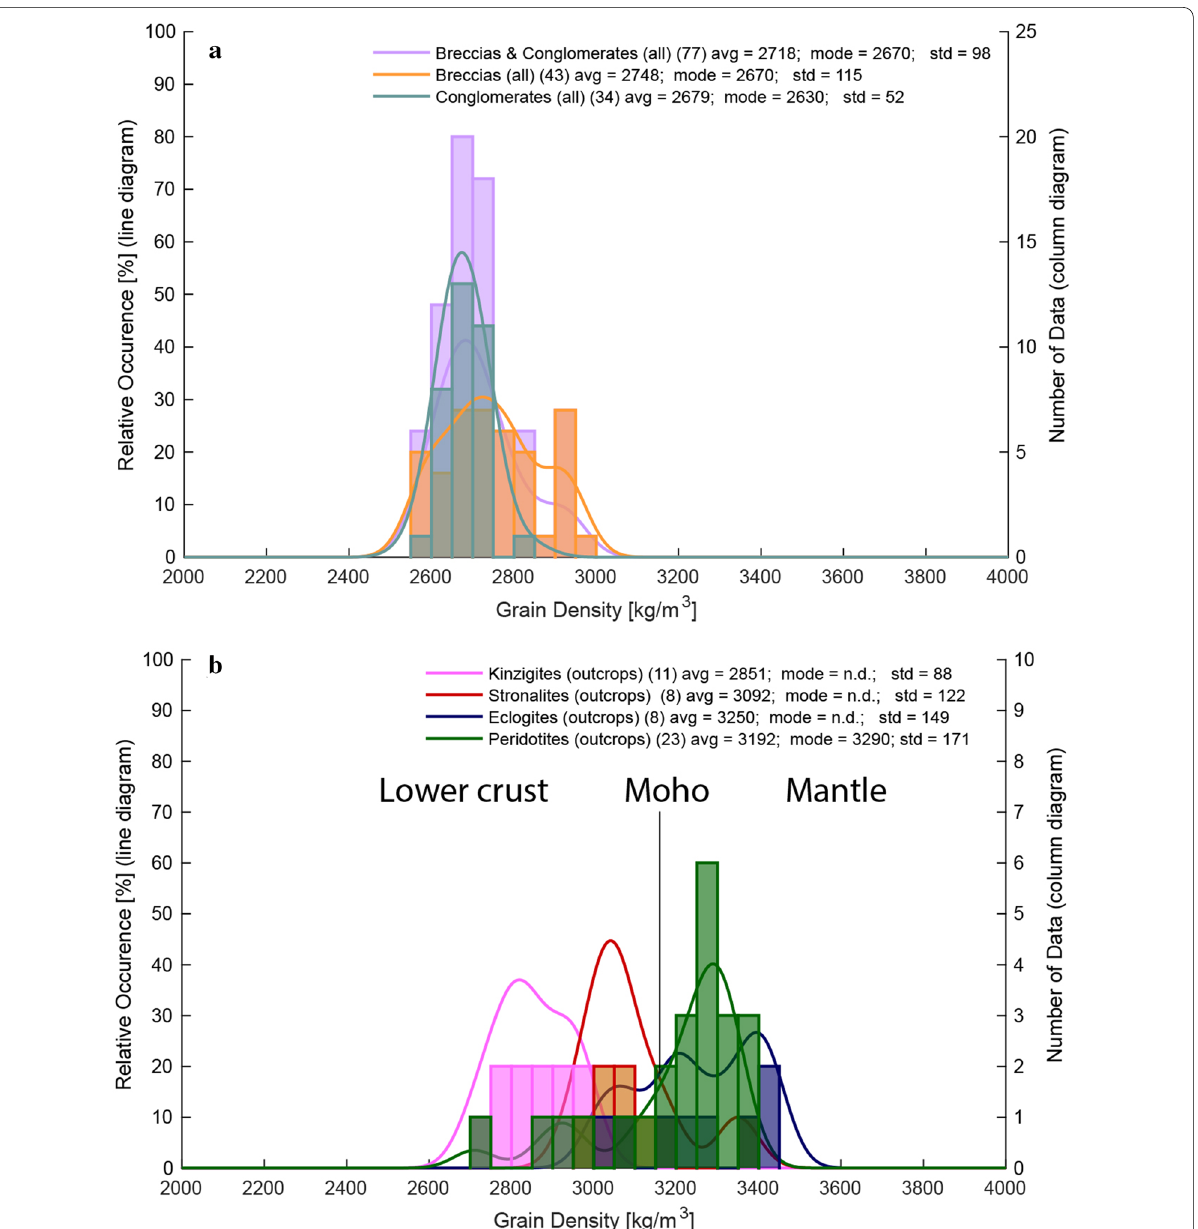
Fig. 6 Examples of density distributions for a breccias and conglomerates and b for lower crustal (kinzingites, stronalites) and uppermost mantle (peridotites, eclogites) lithologies, separated by the crust-mantle boundary (Moho). The diagrams show a visual comparison of block histograms and respective kernel distributions (solid lines) generated from the density data. Histograms refer to the number of data (on the right vertical axis) falling in a specific densities range, here in steps of 50 kg/cm 3 . The numbers in parenthesis represent the total number of data for each distribution. For example, in the case of breccias, 10 of 45 samples available have densities in the range 2900–2950 kg/cm 3 . Solid curves represent the Kernel smoothing function calculated over the density data population and representing the relative occurrence of density values in % (left axis). The Kernel distribution builds a function to represent the probability distribution of the sample data. a The density distributions for conglomerates and breccias (from boreholes and outcrops combined) document a much wider range of values for breccias that, when combined in one single lithology group would indicate two maxima. The mode is also indicated, but not in all cases it could be calculated (n.d not determined). b Density = values for rock types from the Ivrea-Verbano zone. The density distributions of the Kinzingites, Stronalites and Peridotites/Eclogites exhibit three distinctively different maxima reflecting the different mineral and modal composition and documenting the difference in density across the Moho discontinuity between the lowermost crust and the mantle